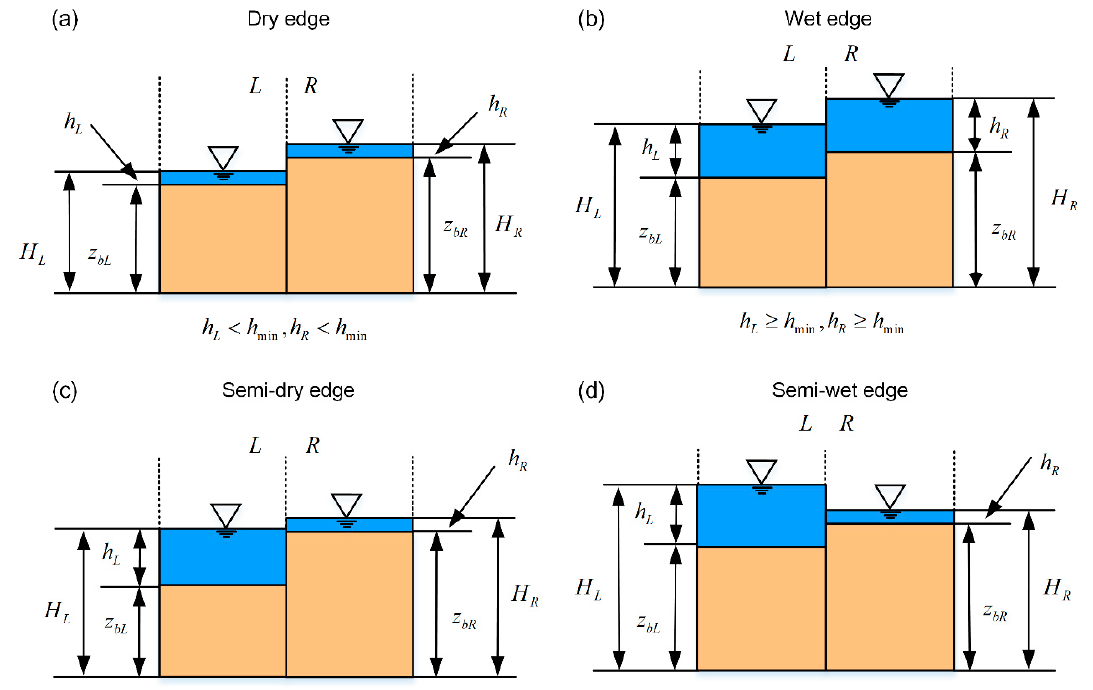
Figure 5. Four types of cell edge delineation.